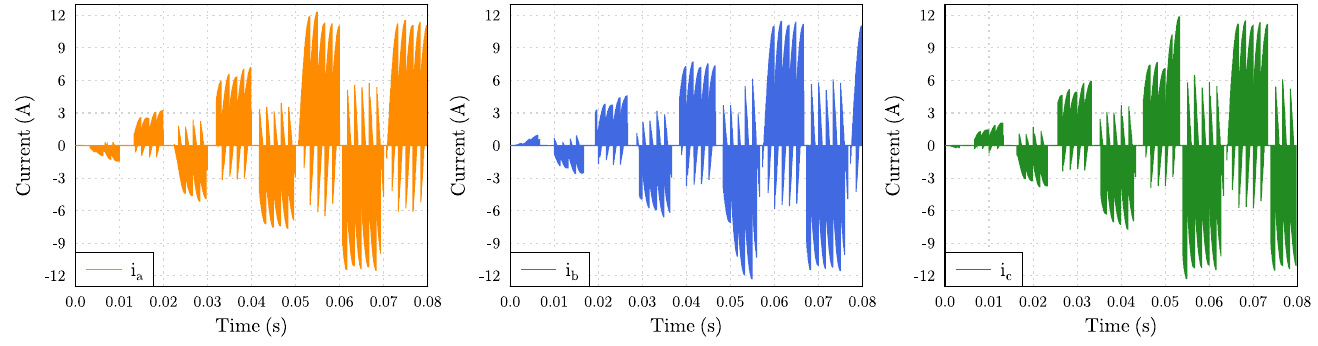
Figure 20. Input currents of the IMC controlled by